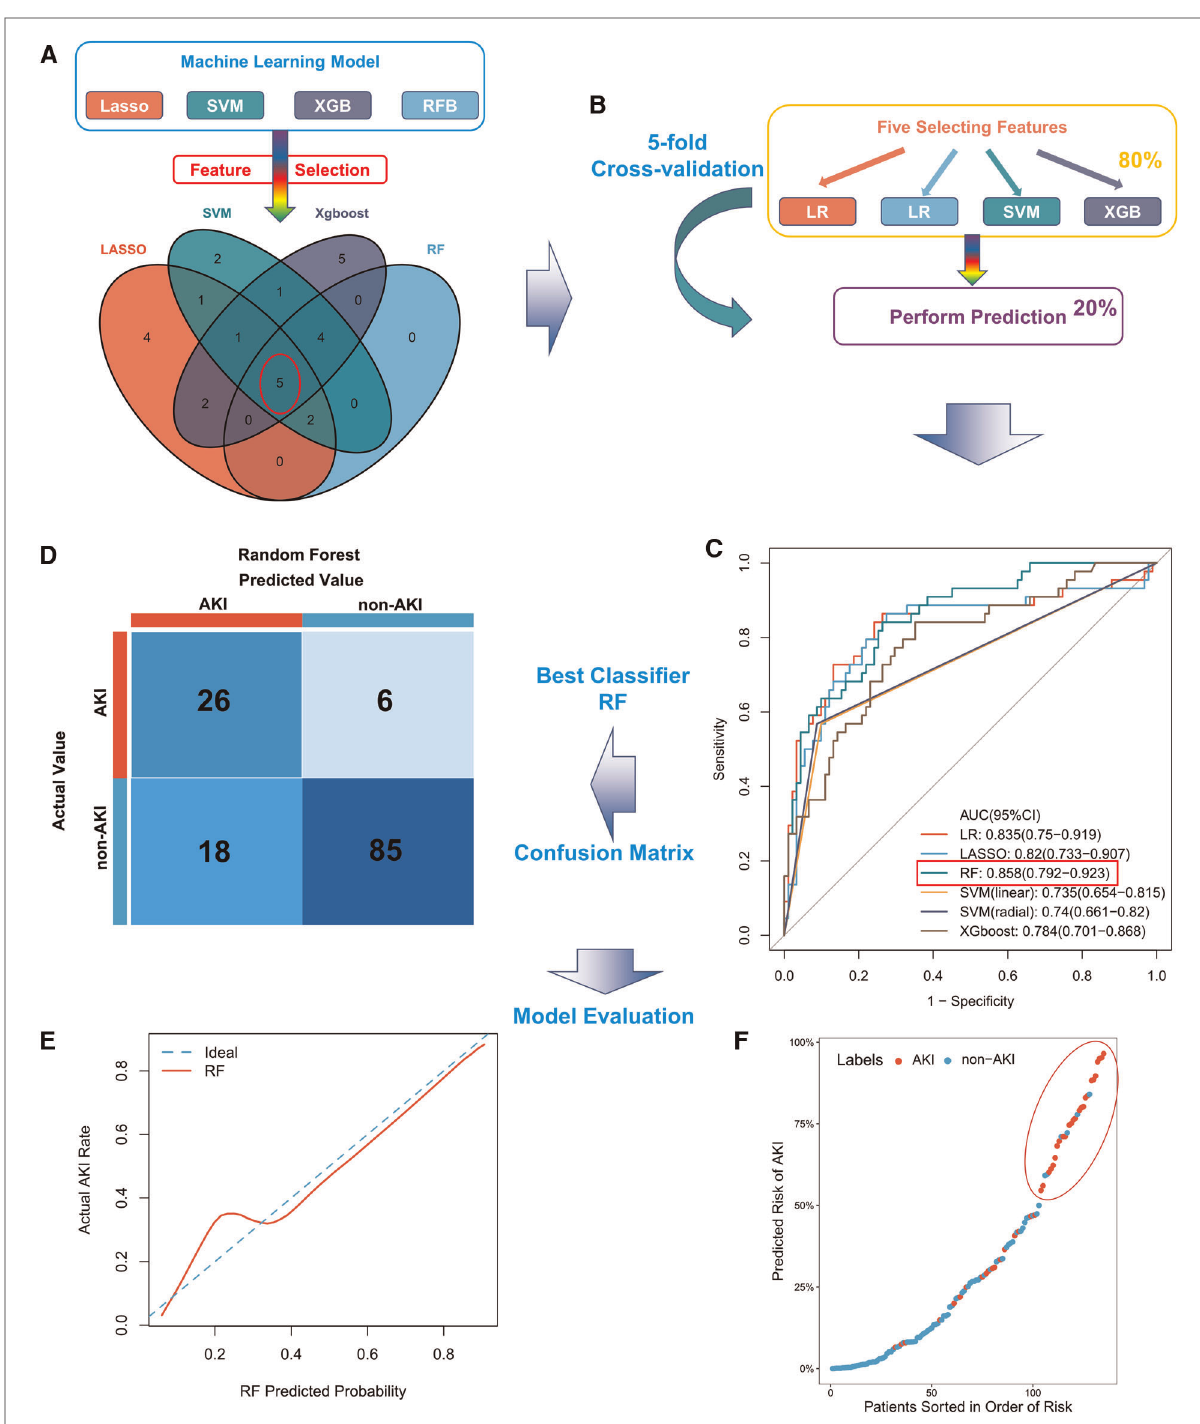
FIGURE 1 Construction and evaluation of the CSA-AKI prediction model. ( A ) The fi ve most important clinical features screened using four machine learning algorithms in the entire cohort; ( B ) schematic diagram of six machine learning algorithms in the training set trained and validated for stable clinical models by fi ve-fold cross-validation; ( C ) comparison of AUC values among machine learning models, with RF having the largest AUC value; ( D ) confusion matrix of the best model (RF) in the entire cohort; ( E ) calibration curve for the RF model; ( F ) distribution of predicted patient risk of CSA-AKI. CSA-AKI: cardiac surgery-associated acute kidney